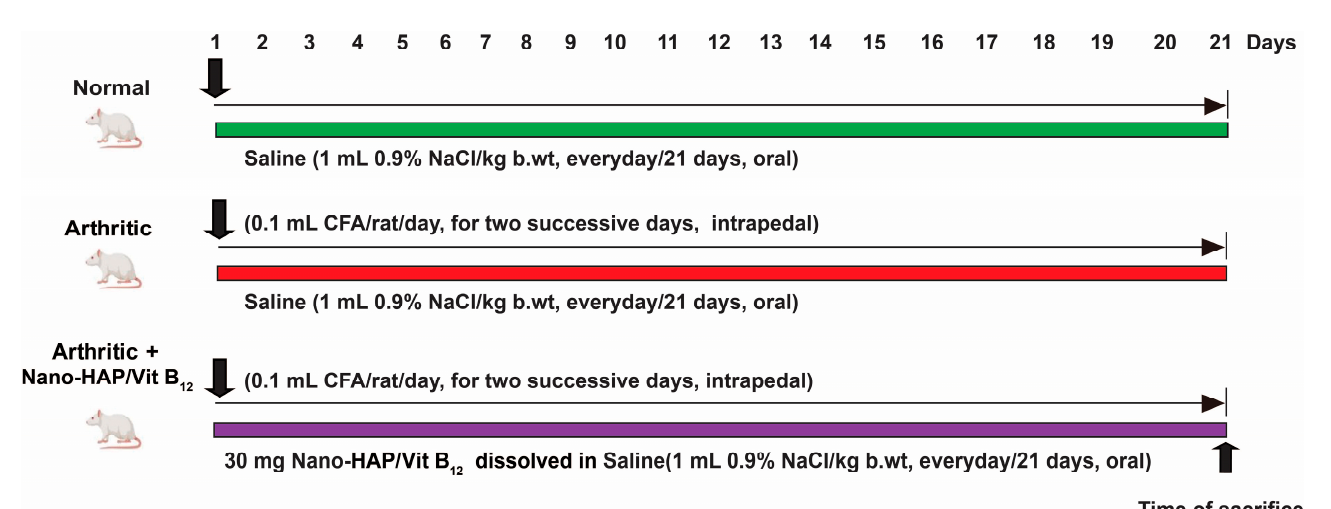
Figure 10. Experimental design and animal